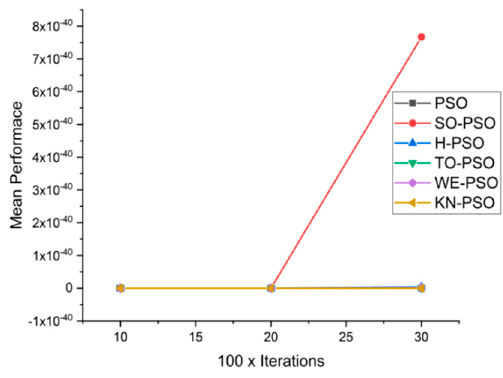
Figure 7. Convergence curve on fn1.